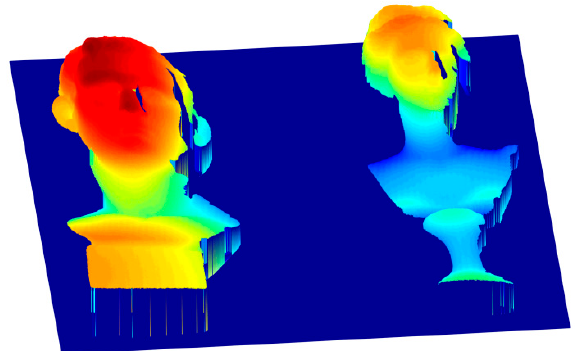
Figure 14. The 3D shape measurement result using the proposed method after correction.